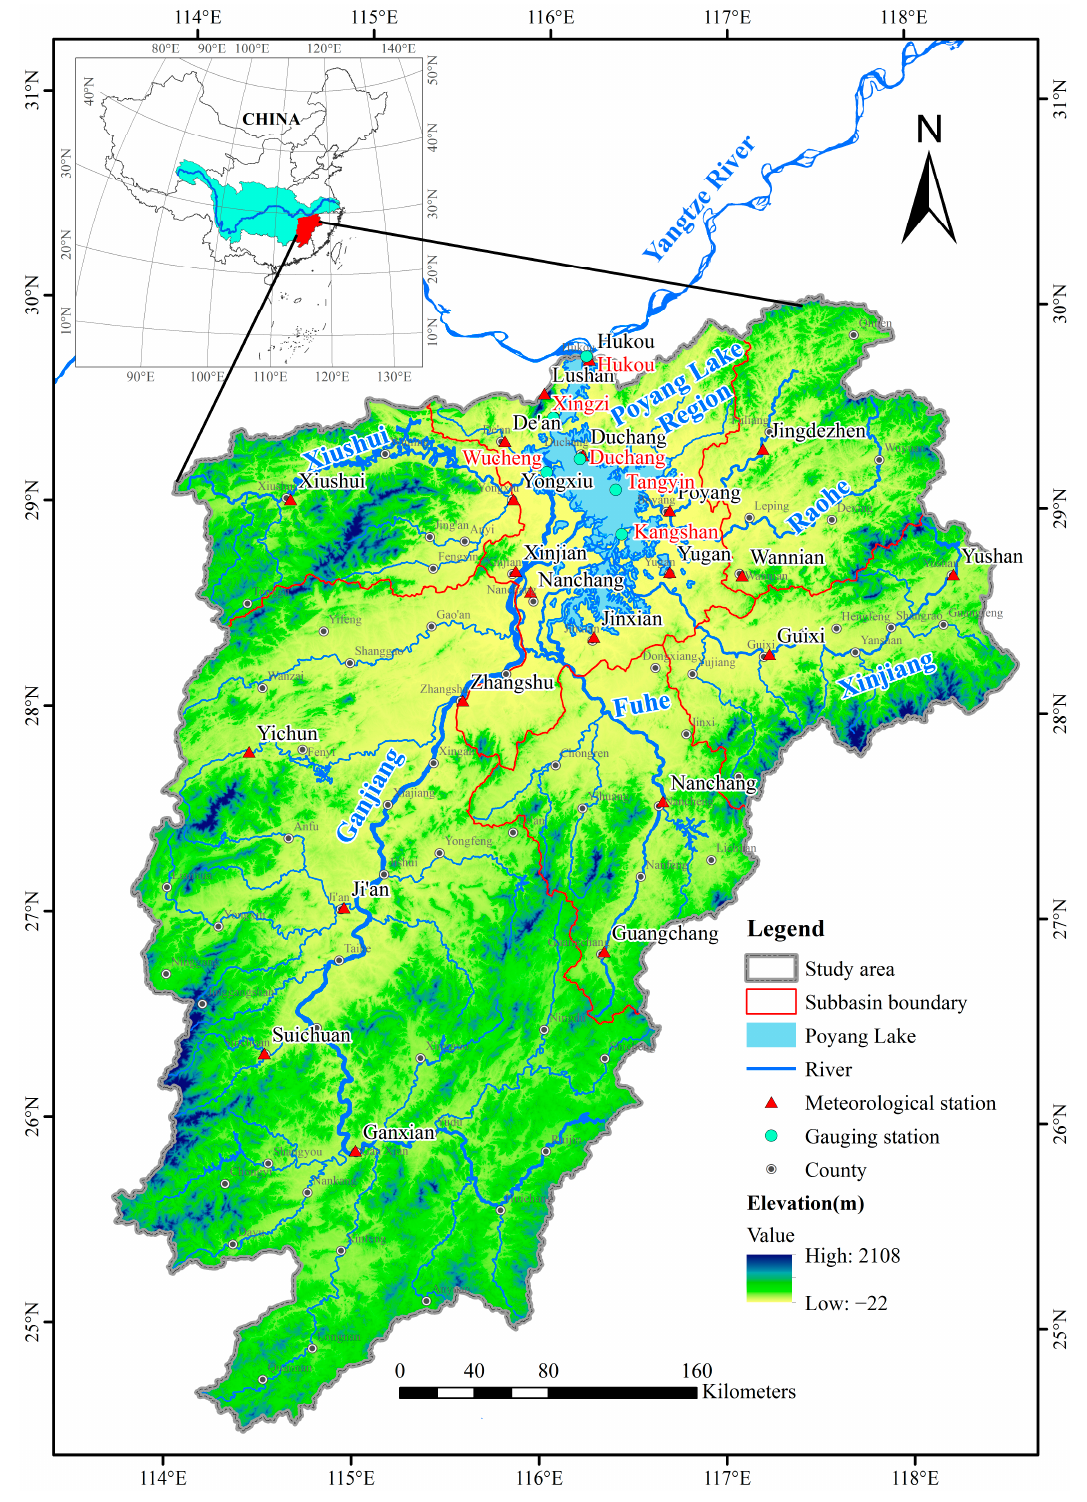
Figure 2. Locations of the Poyang Lake Basin, meteorological and gauging stations.